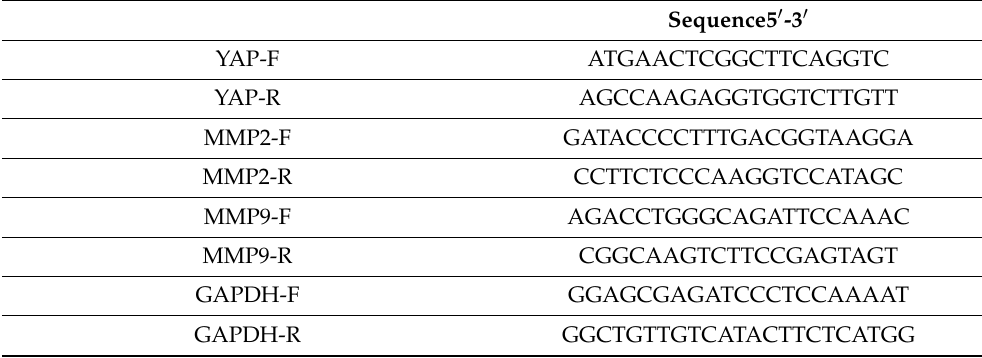
Table 1. Real-time quantitative PCR primer sequences used in this